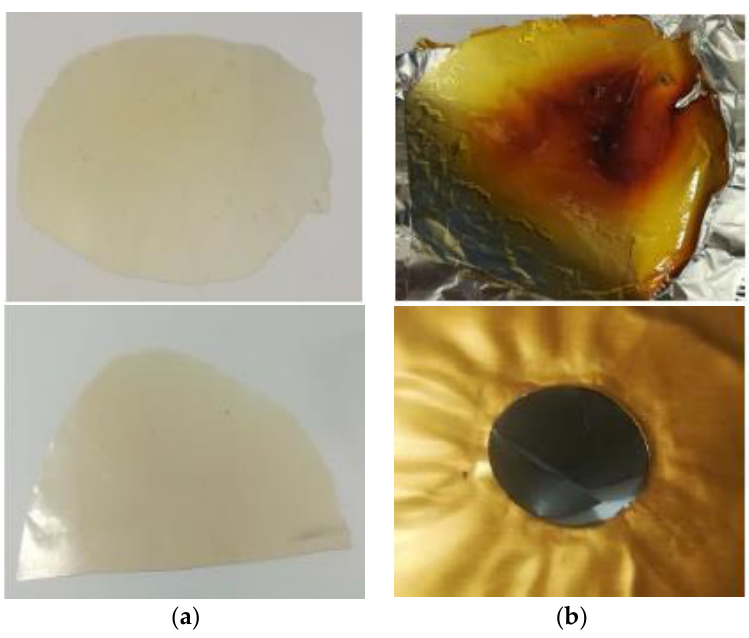
Figure 4. Thin film samples of PEI ( Top ) and PPS ( Bottom ) before ( a ) and after ( b ) the aging process at 200 °C.